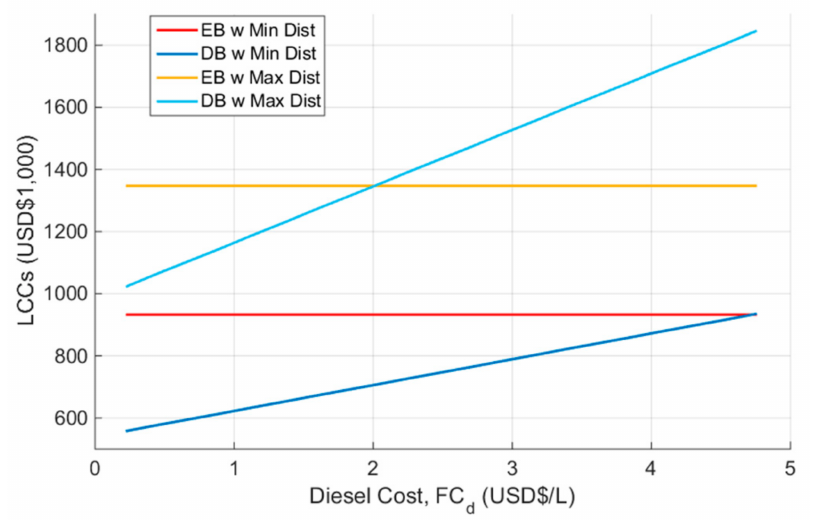
Figure 11. LCCs of electric and diesel buses, against the varying diesel cost for electric prices at current subsidized rate of